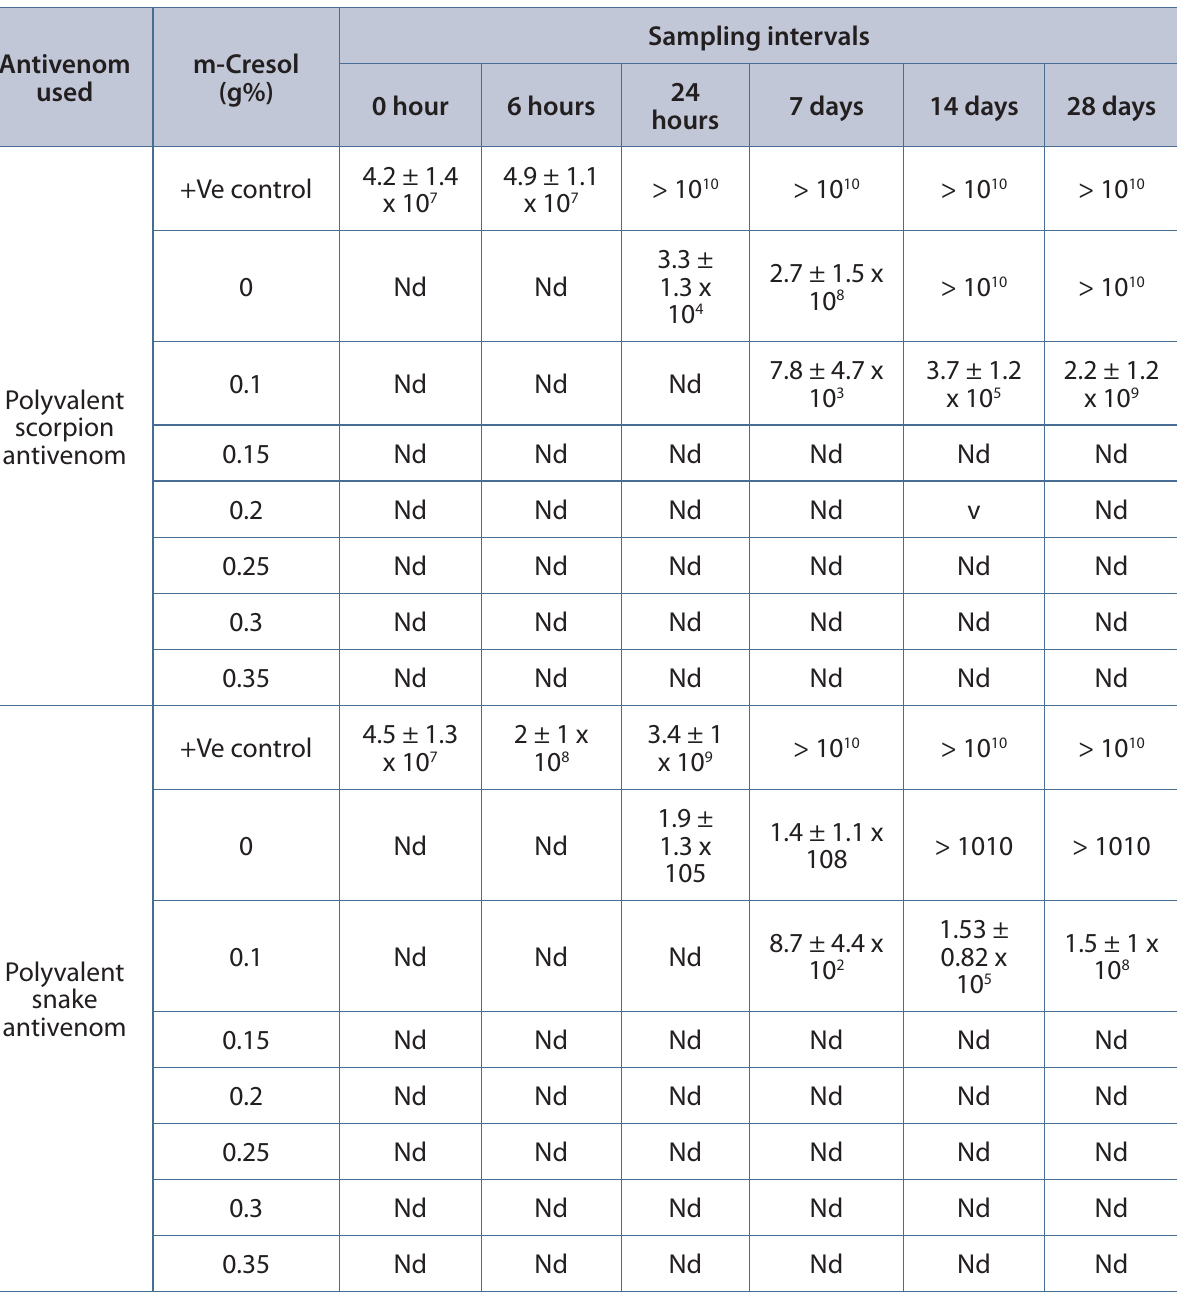
Values represent the mean of six samples followed by their respective standard error of the mean. CFU: colony-forming unit; Nd: not